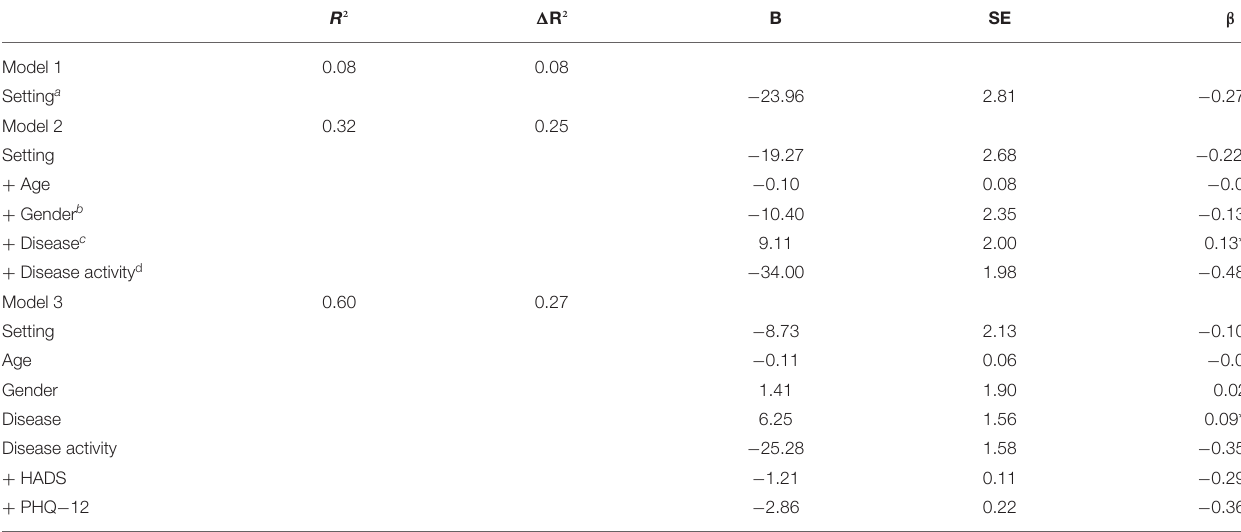
TABLE 2 | Predicting HRQL (IBDQ total score as the dependent variable) from clinical characteristics and psychological symptoms. R ² 1 R ² B SE β Model